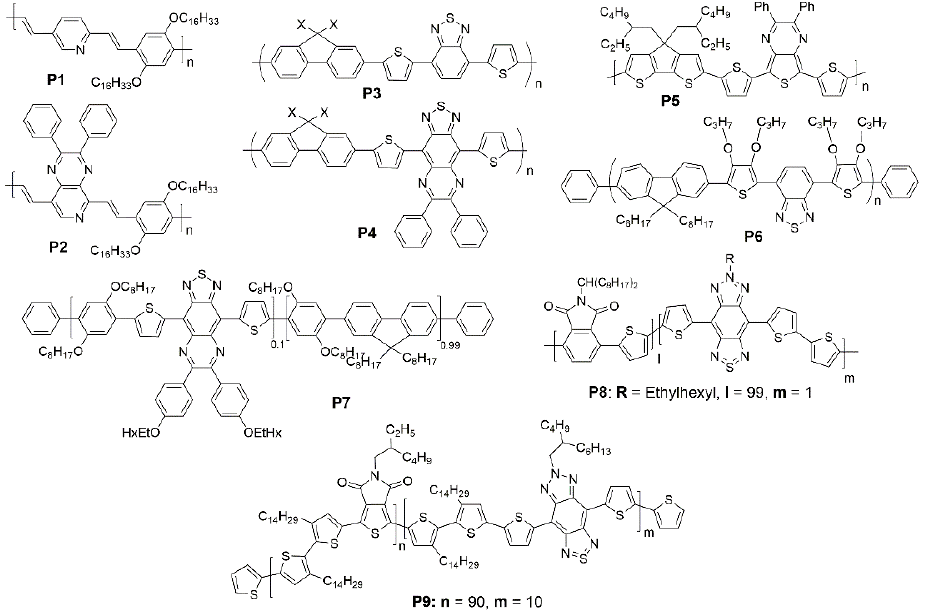
Figure 5. Chemical structures of P1 to P9 .